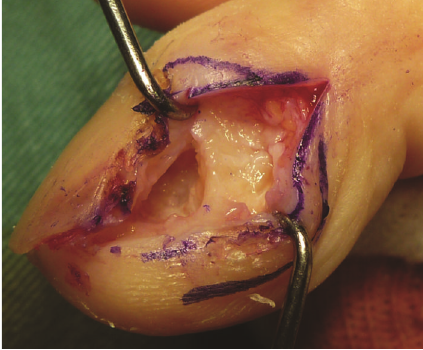
Figure 3: Intraoperative findings showing a partial defect of the ulnar cortical bone of the distal phalanx.